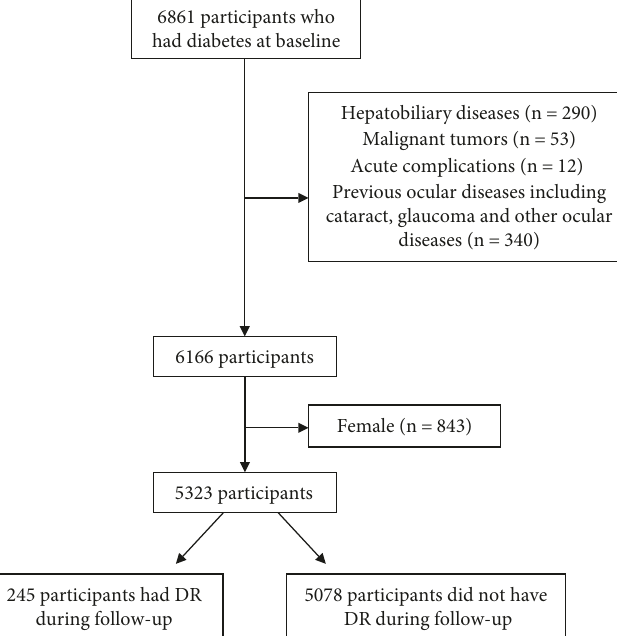
Figure 1: Flow chart of inclusion of